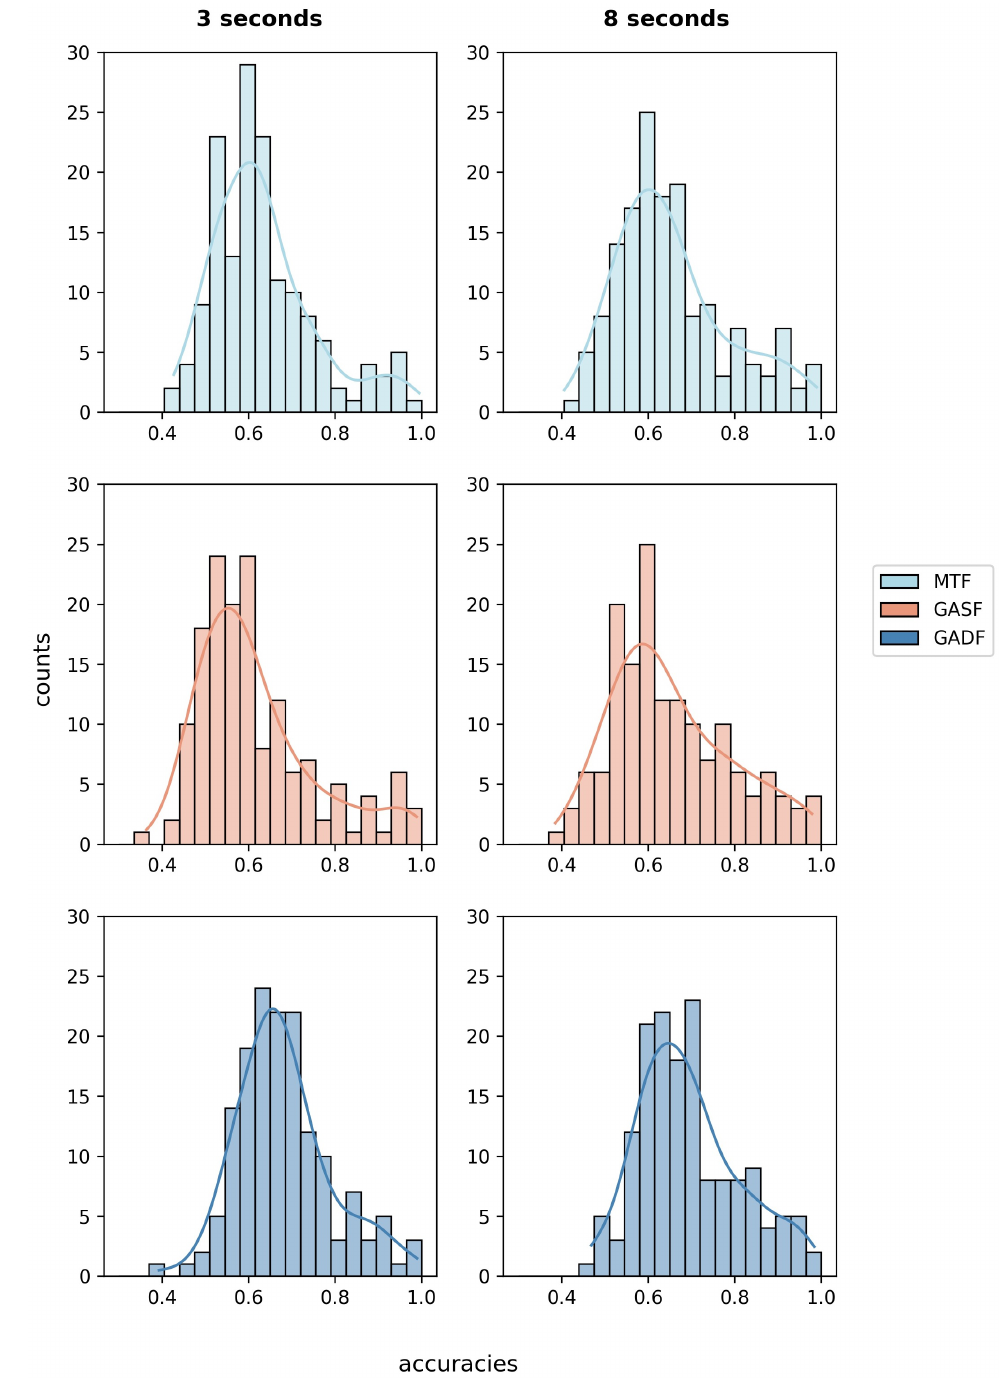
Figure 2. Average fold accuracy per participant represented as histograms. As input features, only the features that were generated using either of the presented algorithms were used. The histograms on the left show the results for the 3 s windows, while the histograms on the right represent the 8 s